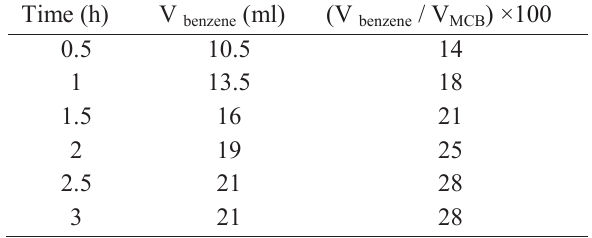
Catalytic test results for C1 catalyst.